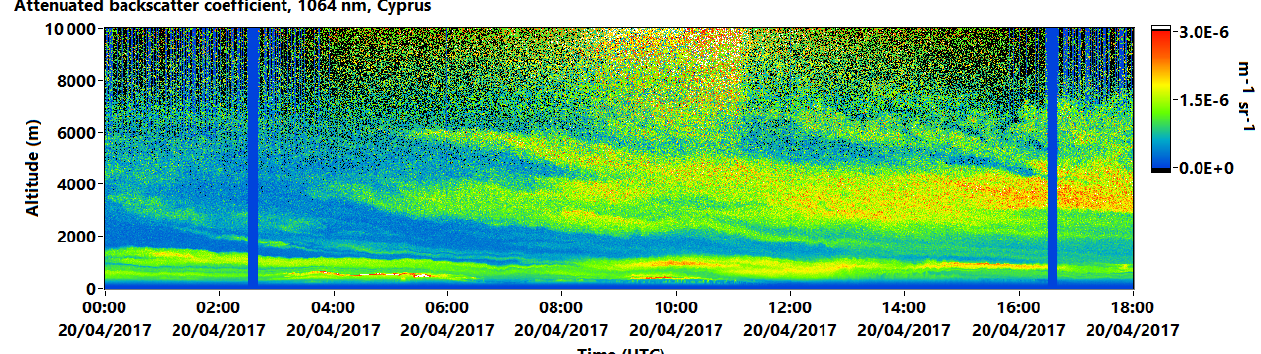
Figure 14. The 1064nm attenuated backscatter (in m − 1 sr − 1 ) measured by a Polly XT lidar at the LACROS site on 20 April